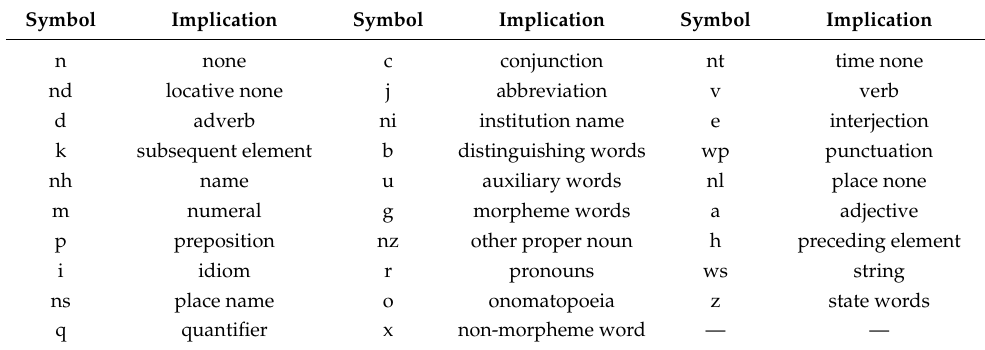
Table 2. The 863 POS set.